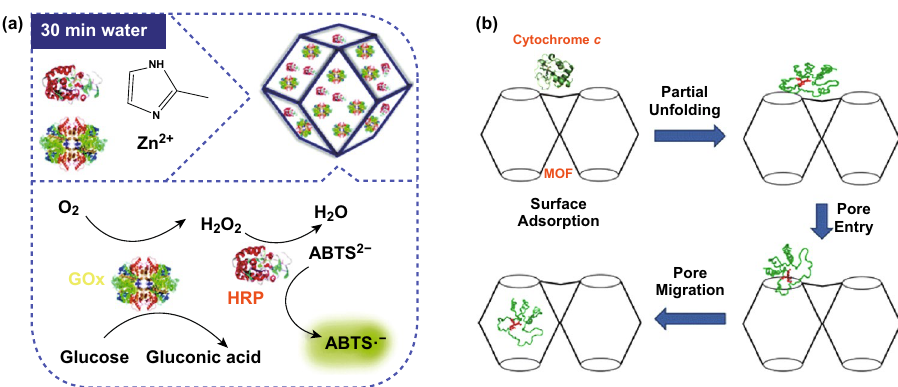
Fig. 2 a One-step synthesis of ZIF-8 nanocrystals embedding multiple enzymes GOx and HRP. Reproduced with permission from Ref. [56]. Copyright 2015, The Royal Society of Chemistry. b Mechanism of Cyt c translocation into the MOF interior through relatively small windows. Reproduced with permission from Ref. [59]. Copyright 2012, American Chemical